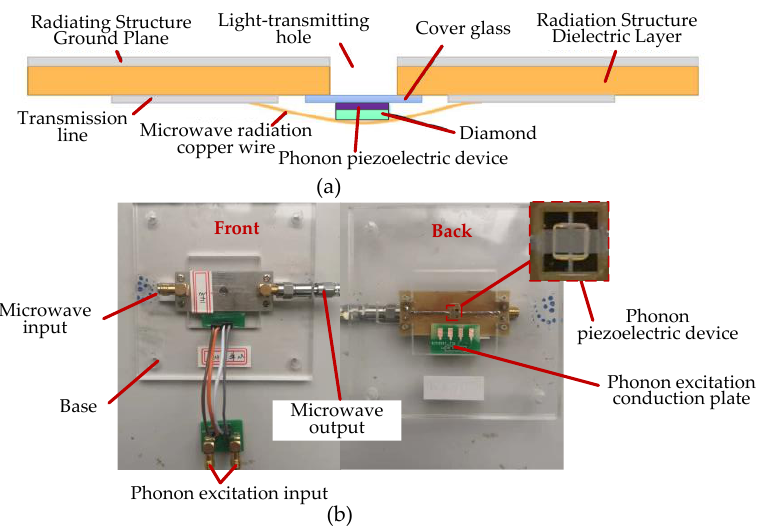
Figure 21. Phonon-coupled radiation structure and its physical photograph: ( a ) phonon-coupled radiation structure; ( b ) physical photograph.